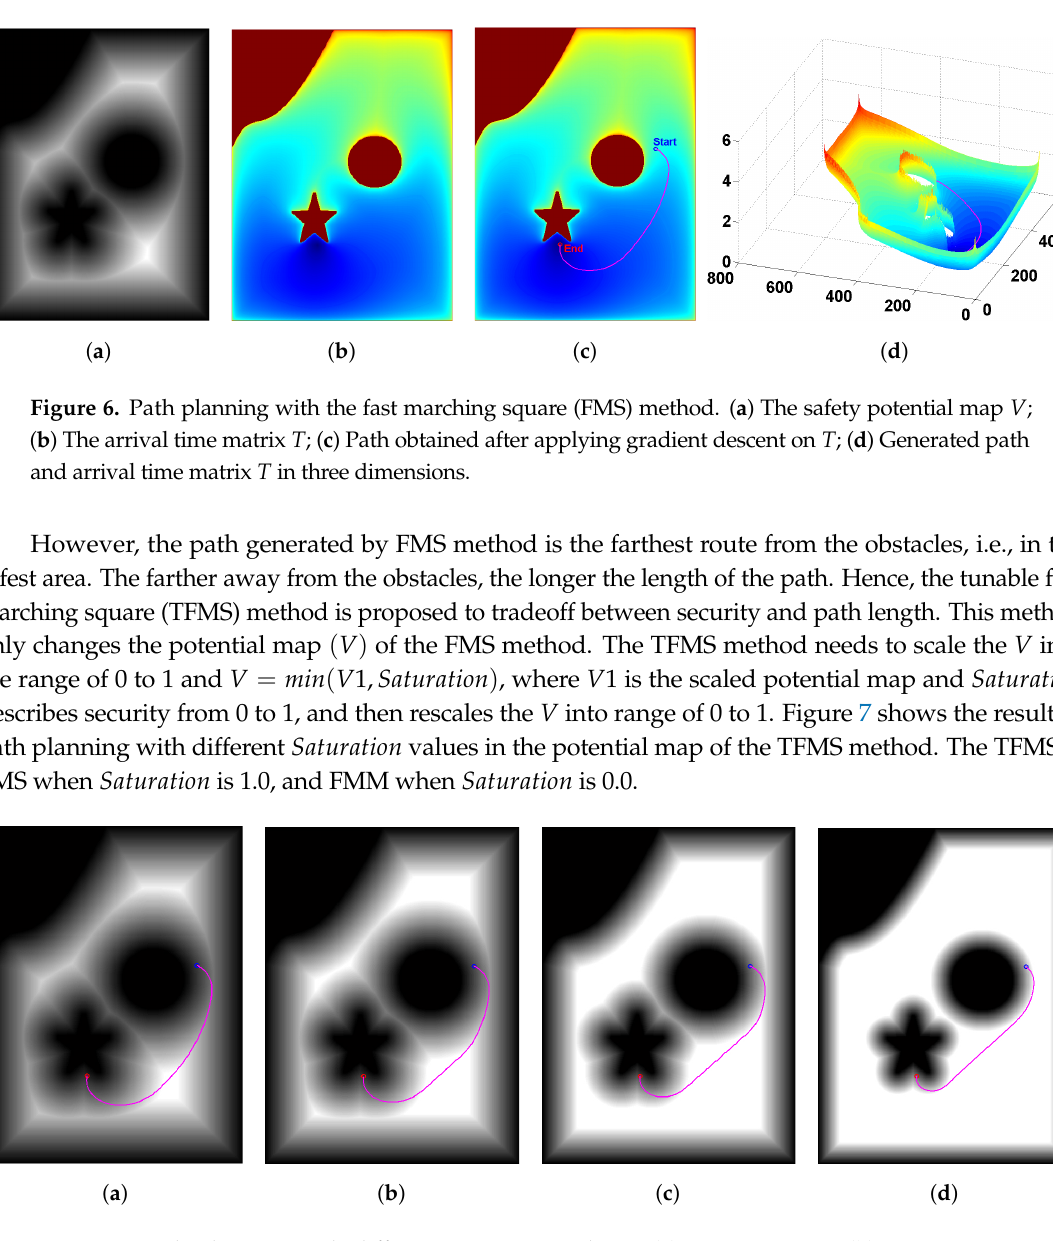
Figure 7. Path planning with different Saturation values. ( a ) Saturation 0.9; ( b ) Saturation 0.7; ( c ) Saturation 0.5; ( d ) Saturation